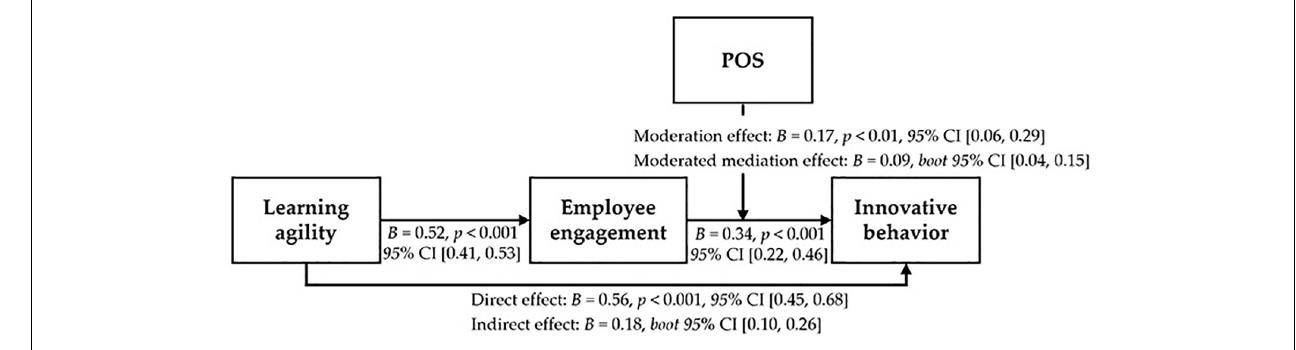
FIGURE 3 | Results for the testing hypothesis.